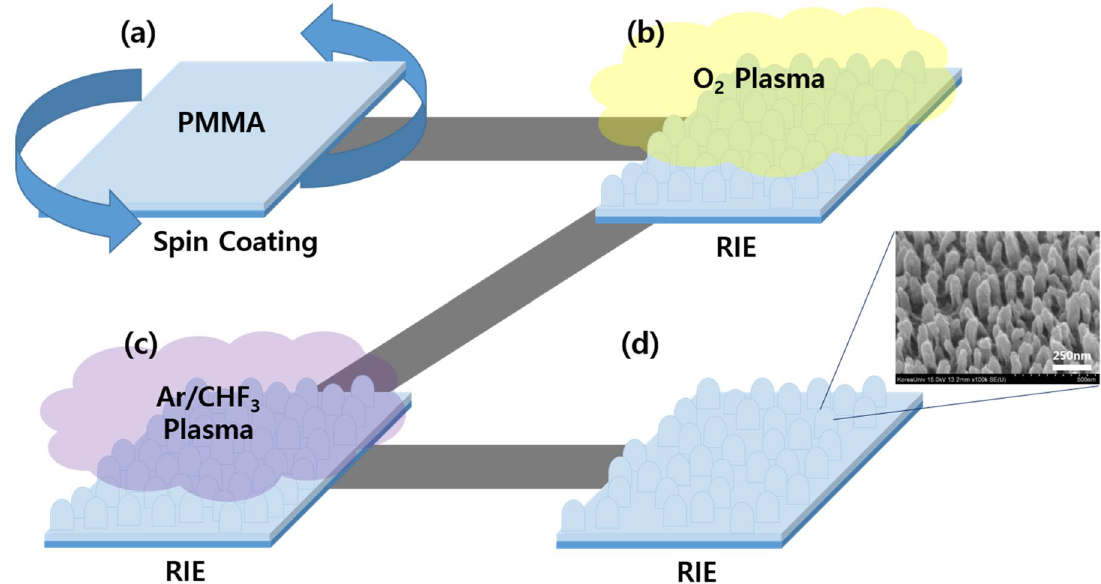
Figure 7. Fabrication of the diffusion layer with the nano-sized structures: ( a ) PMMA is spin coated onto the substrate, ( b ) PMMA etching via RIE O 2 plasma, ( c ) PMMA etching via RIE Ar/CHF 3 plasma, and ( d ) fabricated diffusion layer with the nano-sized